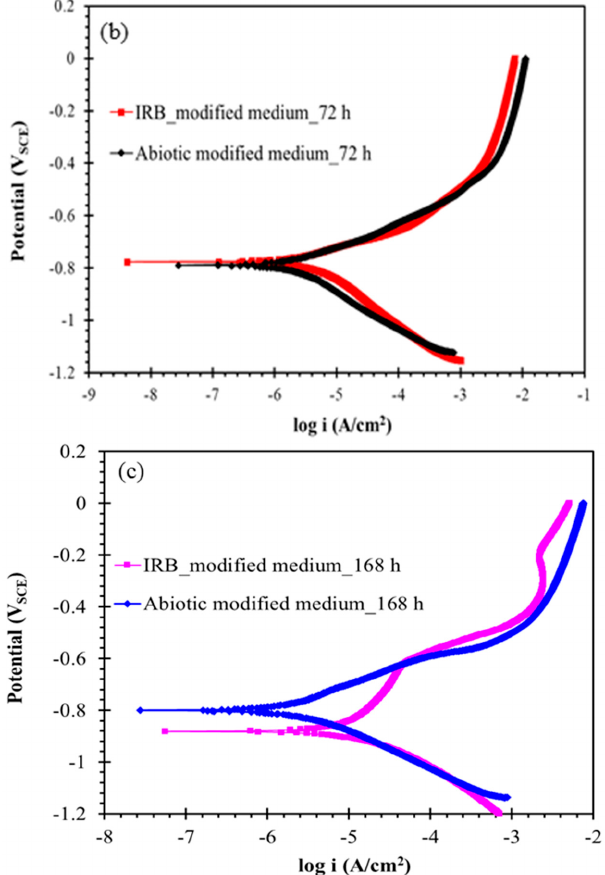
Figure 10. ( a ) Change in OCP of carbon steel with time of exposure to a modified Postgate C medium with pure IRB culture and without the culture (abiotic). ( b ) Potentiodynamic polarization scans of carbon steel after 72 h exposure in modified Postgate C medium with and without IRB. ( c ) Potentiodynamic polarization scans of carbon steel after 168 h exposure in modified Postgate C medium with and without